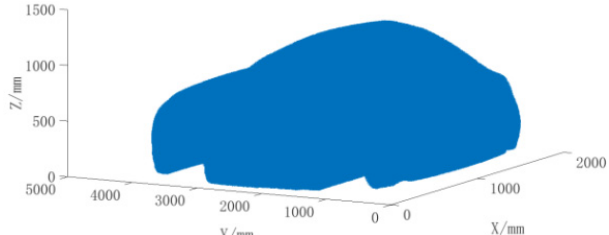
Figure 21. The STL analysis model of a car.